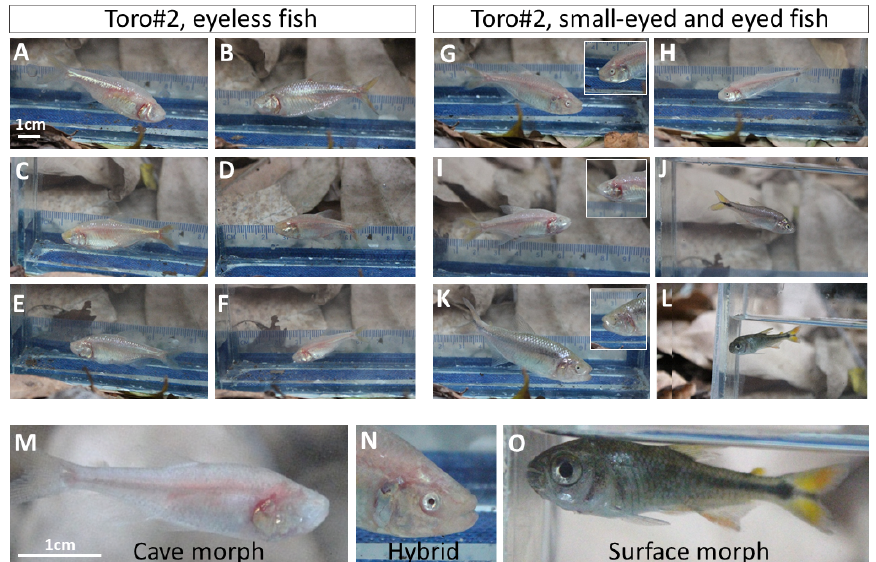
Figure 9. High variability in the eye and pigmentation level within the population inhabiting the Toro system. ( A – F ); Eyeless fish. ( G – L ); Small eyed and large eyed fish. ( M – O ); Higher magnification of representative morphs. Introgression between the surface morph and the cave morph is suggested by the presence of individuals that are highly depigmented, but with eyes ( G , H , K ) or individuals with pigment, but reduced eyes ( J ). Asymmetry is evident in some individuals ( K ) in which on one side they may have an eye, but on the other is eyeless (inset photo). Scale bar in A is for ( A – L ) and scale bar in M is for ( A – O